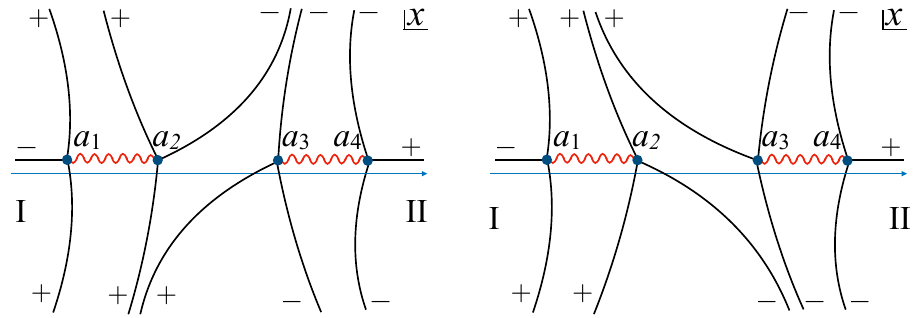
Figure 6 . The Stokes graph for the double-well potential with Im ~ > 0 (Left panel) and Im ~ < 0 (Right panel). We took the two branch cuts such that their end-points are turning points ( a 1 , a 2 ) and ( a 3 , a 4 ). We take the orbit for obtaining the quantization condition from the left to the right below the real